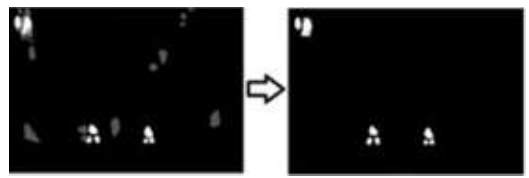
Figure 22. Finding common regions on images of Fig. 21.